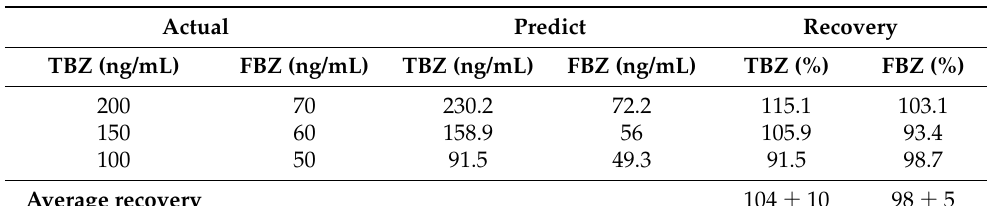
Table 4. Predicted results of the actual spiked samples.